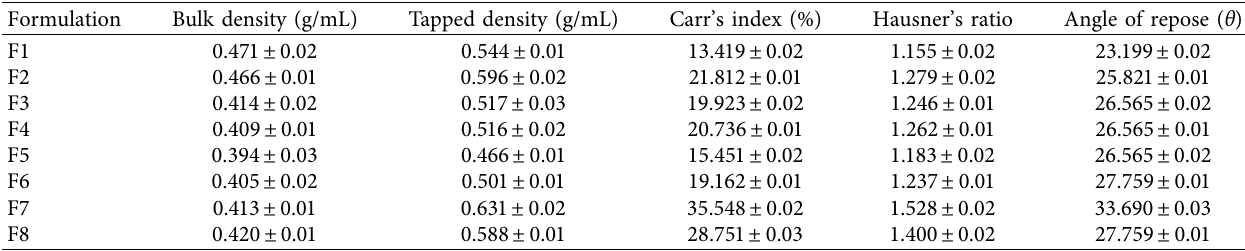
Table 4: Flow properties of formulated granules from Melia